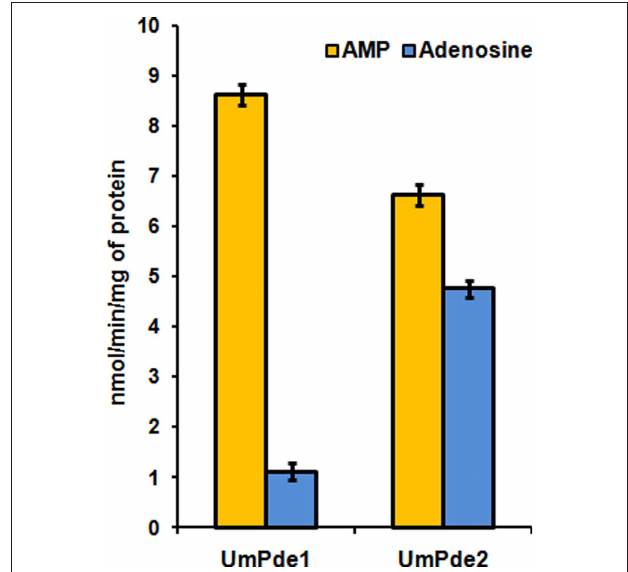
Figure 4 | Specific activities of umPde1 and umPde2. cAMP was converted into AMP by both the enzymes. Both UmPde1 and UmPde2 were able to convert AMP into adenosine, though this activity was more pronounced in UmPde2. Bars indicate standard deviation obtained from three independent replicate assays for each